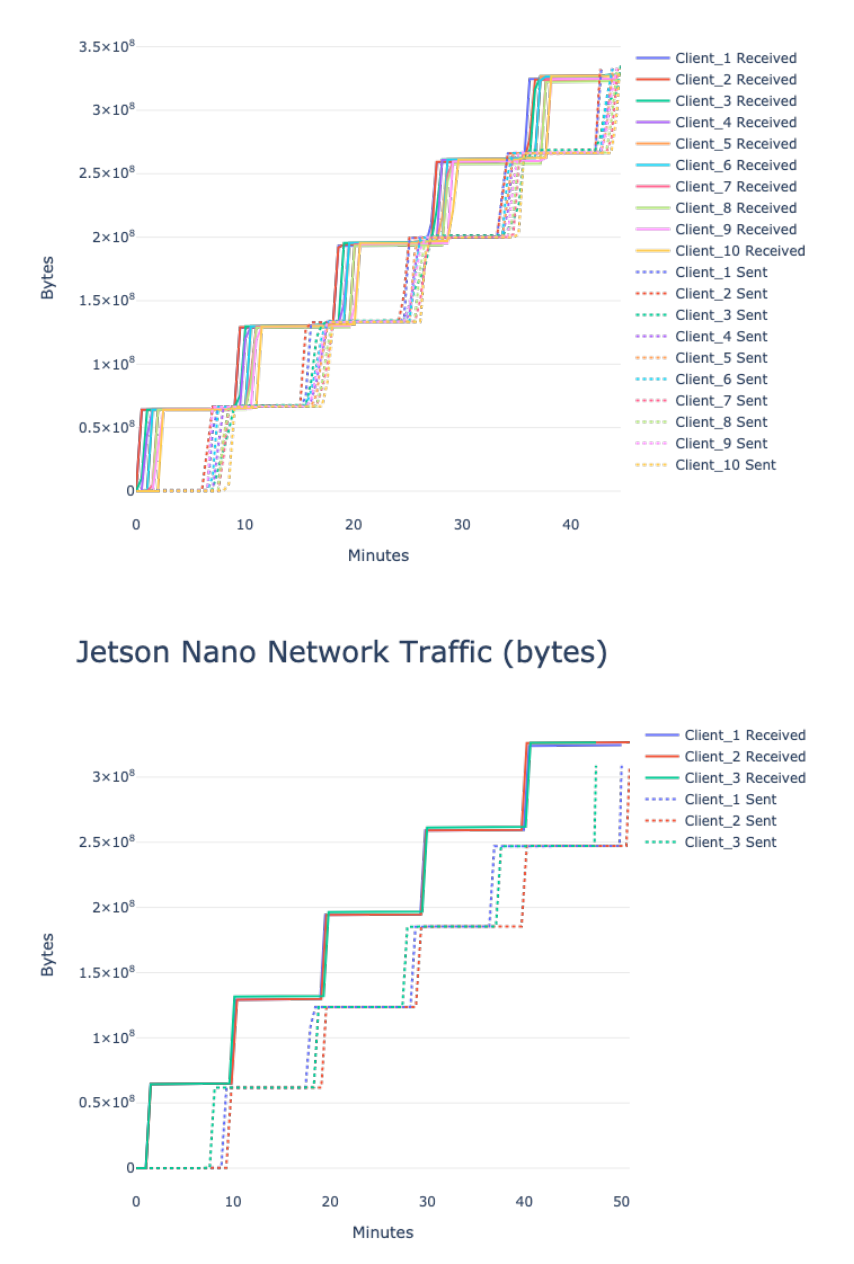
Figure 14. Network traffic comparison for different Raspberry Pi and Jetson Nano devices. The x-axis represents the time in minutes, the y-axis represents network traffic in